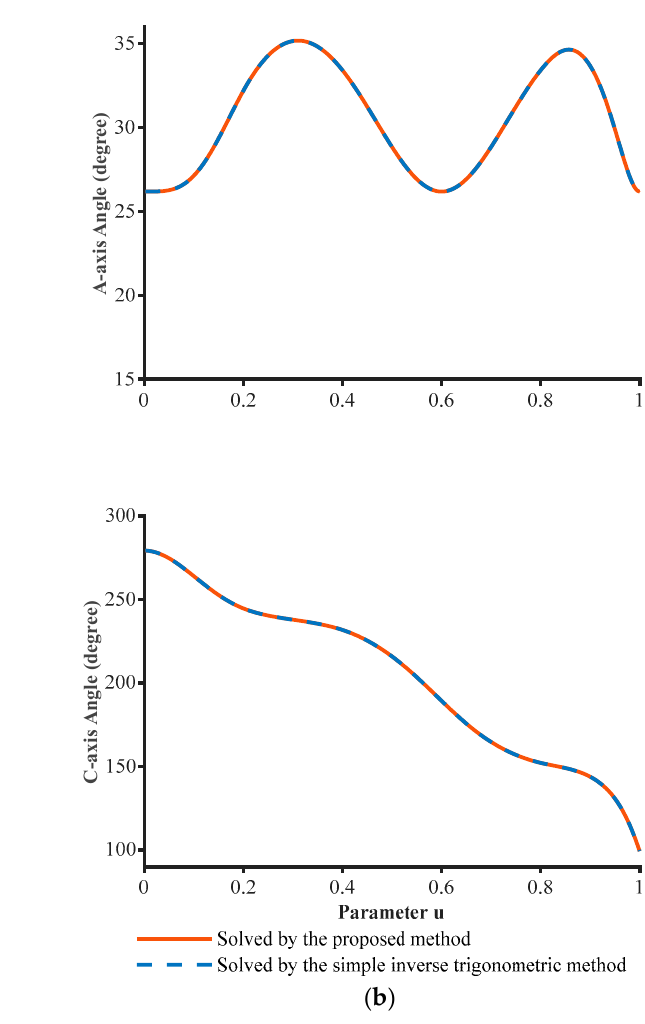
Figure 6. The rotation-angle results of the open-pocket curve. ( a ) The rotation angles of the machine tool with dual orthogonal turntables. ( b ) The rotation angles of the machine tool with dual pendulous turntables.